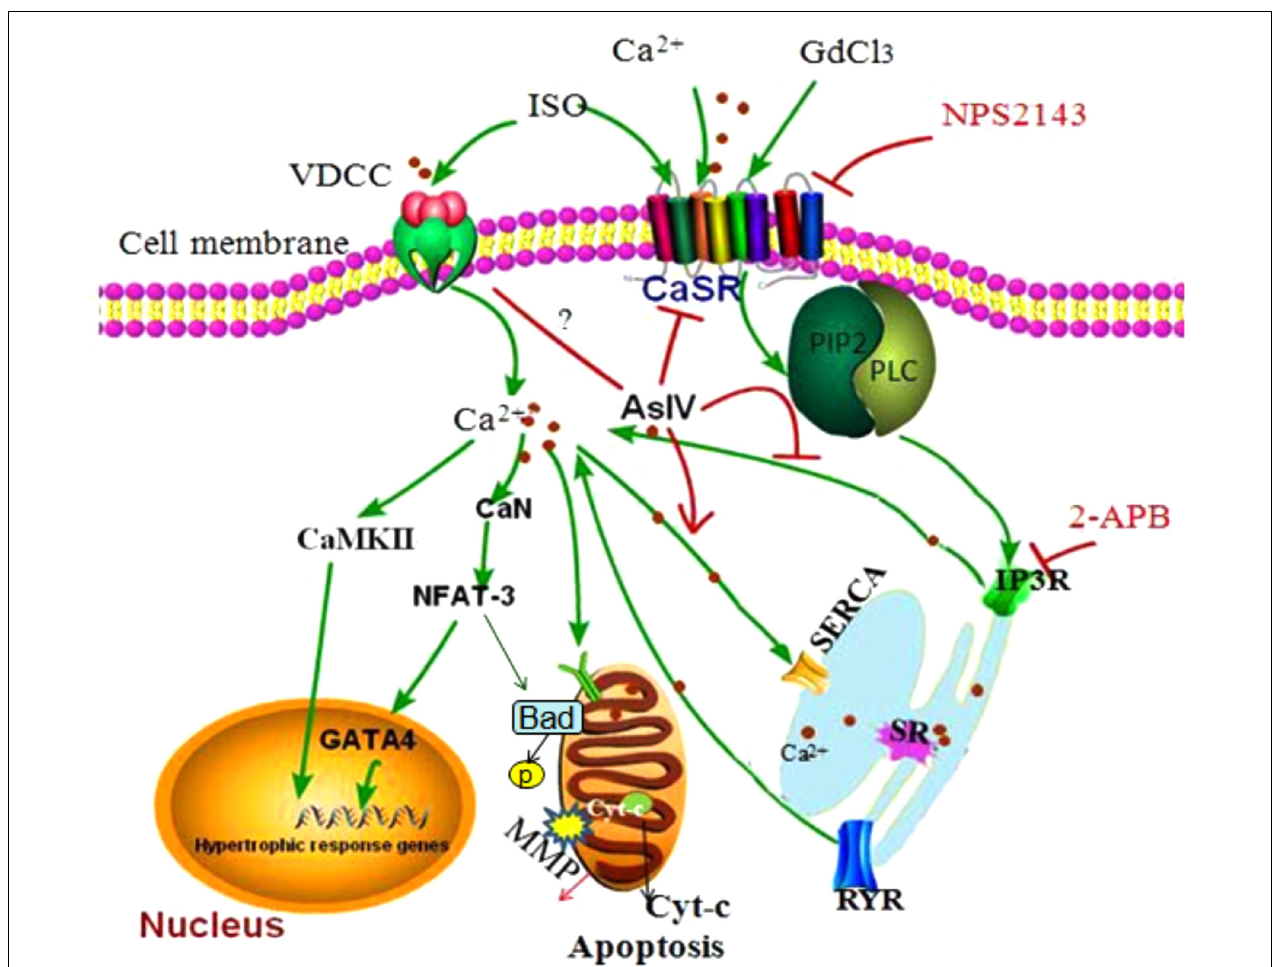
FIGURE 10 | The diagram demonstrating the mechanism of cardioprotection by AsIV via downregulation of CaSR. The stimulation of cardiomyocytes by excessive extracellular Ca 2 + , Iso and GdCl 3 induces overload of [Ca 2 + ] i through CaSR/IP3R pathway. The increased [Ca 2 + ] i leads to activation of CaMKII and CaN signaling pathway, resulting in cardiac hypertrophy and apoptosis. AsIV inhibits cardiac hypertrophy and apoptosis through downregulation of CaSR and IP3R expression and activation of SERCA